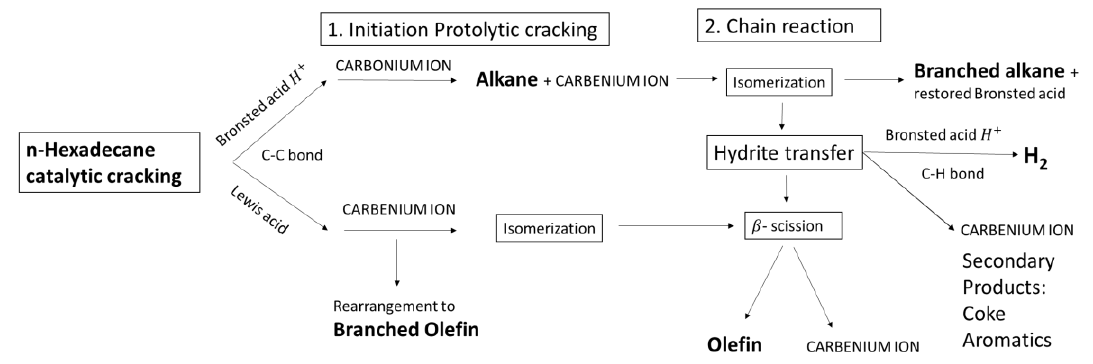
Figure 12. Proposed reaction mechanism of n-hexadecane